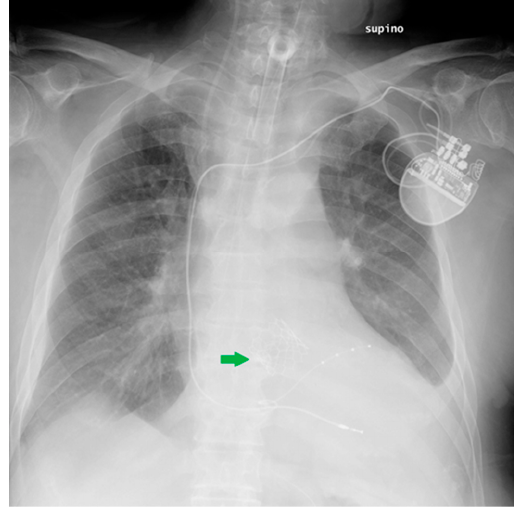
Figure 18. This CXR shows the result of a transcatheter aortic valve implantation (TAVI) (green arrow). The radiogram also includes a PM, a tracheostomy tube and a right jugular CVC.